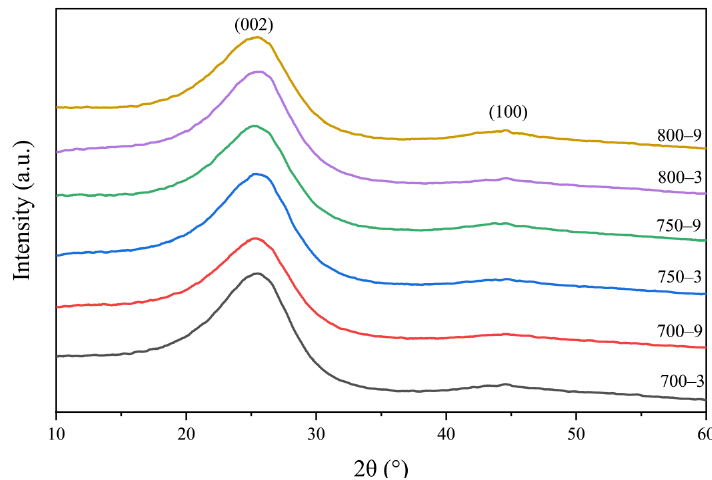
Figure 9. X-ray diffraction patterns of the samples. The L c , L a ⊥ and L a // of the samples were calculated according to Equation (2) and the d 002 was calculated according to Equation (3) [37]. In Table 3, the L c , L a ⊥ and L a // of 700-3, 750-3, 800-3, 700-9, 750-9 and 800-9 gradually increased and the d 002 of 700-3, 750-3, 800-3, 700-9, 750-9 and 800-9 gradually decreased. The crystallite size of 700-3, 700-9, 750-3, 750-9, 800-3 and 800-9 gradually increased, indicating that the size of the graphite-like crystallite in the fibers gradually increased as the heat treatment temperature or the heat treatment time increased. In the experiment, the influence of the heat treatment temperature on the size of the crystallite was greater than the heat treatment time. Combining Figure 3 and Table 3, the change in the crystallite size was consistent with the change in resistivity of 700-3, 700-9, 750-3, 750-9, 800-3 and 800-9 when the test temperature increased from 30 to 100 ◦ C. It indicated that the crystallite size may affect the temperature sensitivity in the proportion of the graphite-like